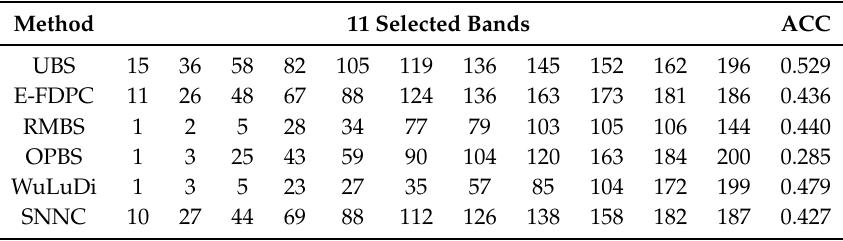
Table 2. Number of recommended bands on Indian Pines data set.